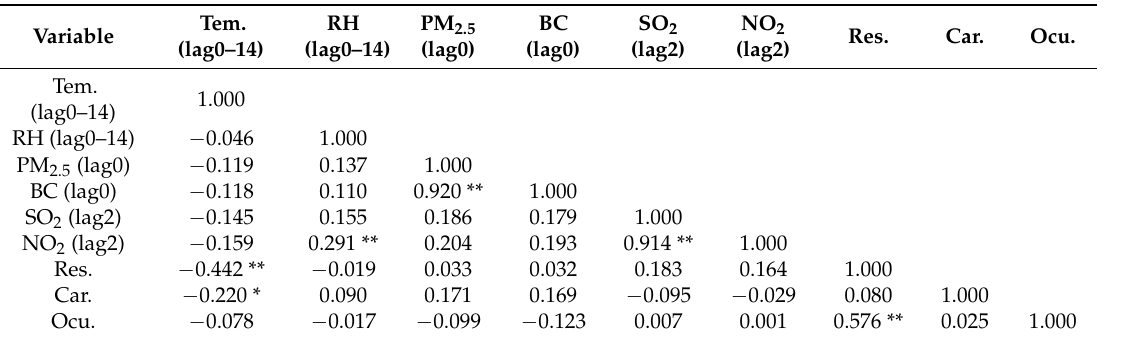
Table 2. Coefficient for the relationship between daily environmental variables and hospital emergency